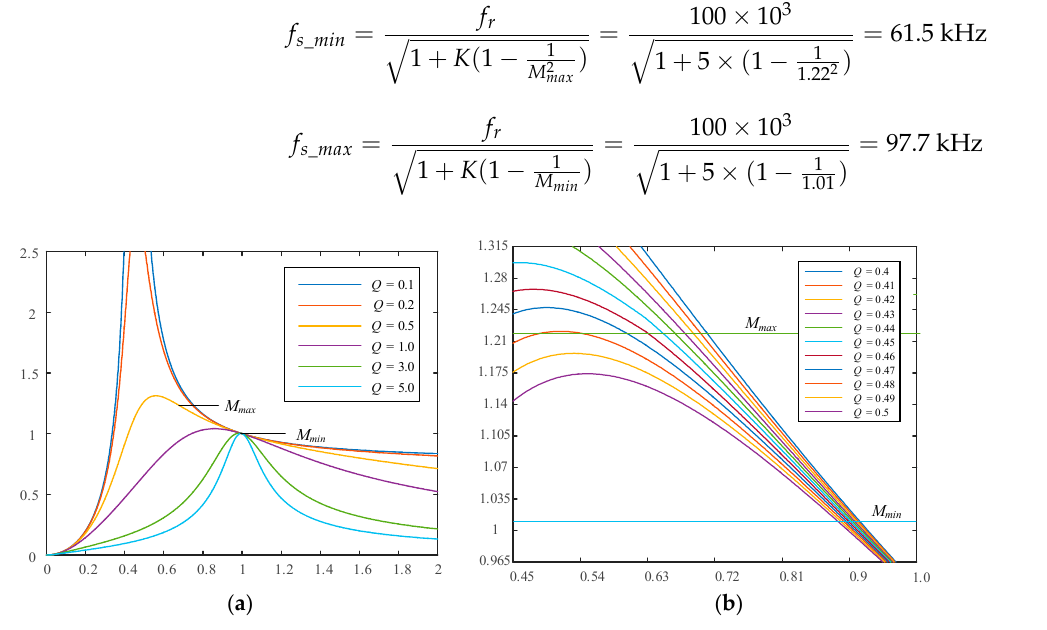
Figure 12. Voltage gain with K = 5: ( a ) original; ( b ) zoom-in.